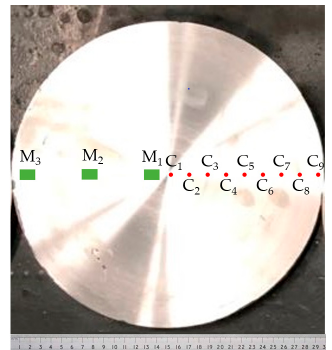
Figure 4. Differential-scanning-calorimetry curves of 7075 alloy.